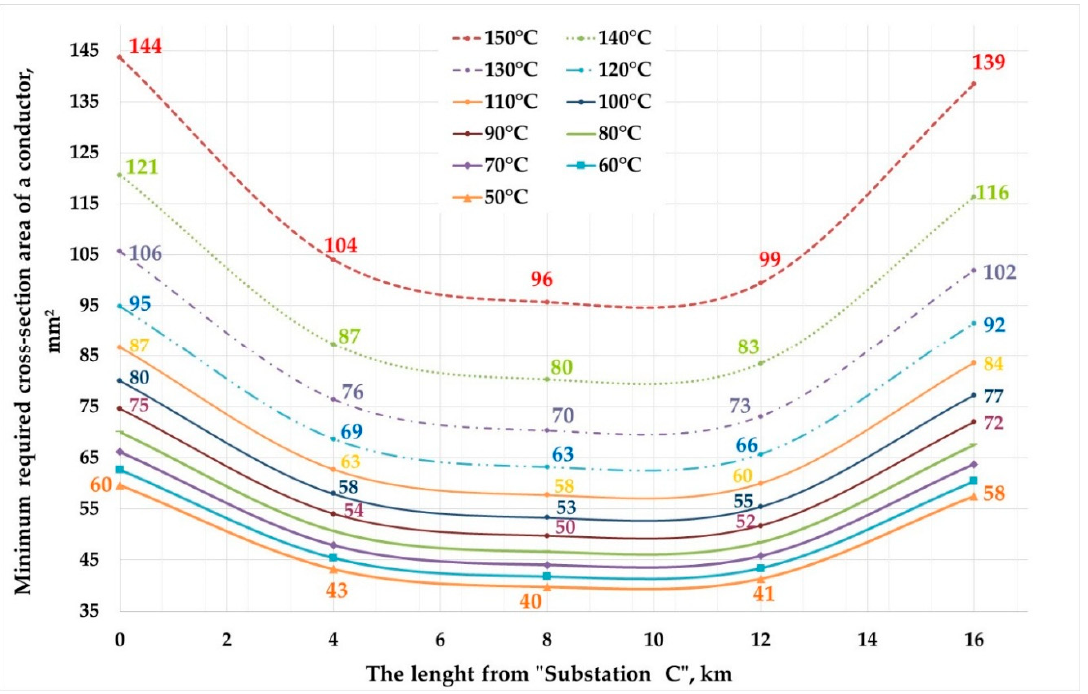
Figure 7. Selected cross-sectional areas of conductor along “OHL No.2” from “Substation C” (zeroth km) toward “Substation B” (17th km).